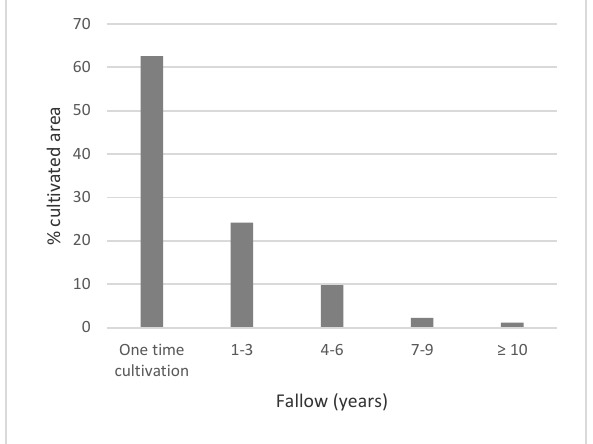
Figure 5. Chart showing the percent of area cultivated under various fallow